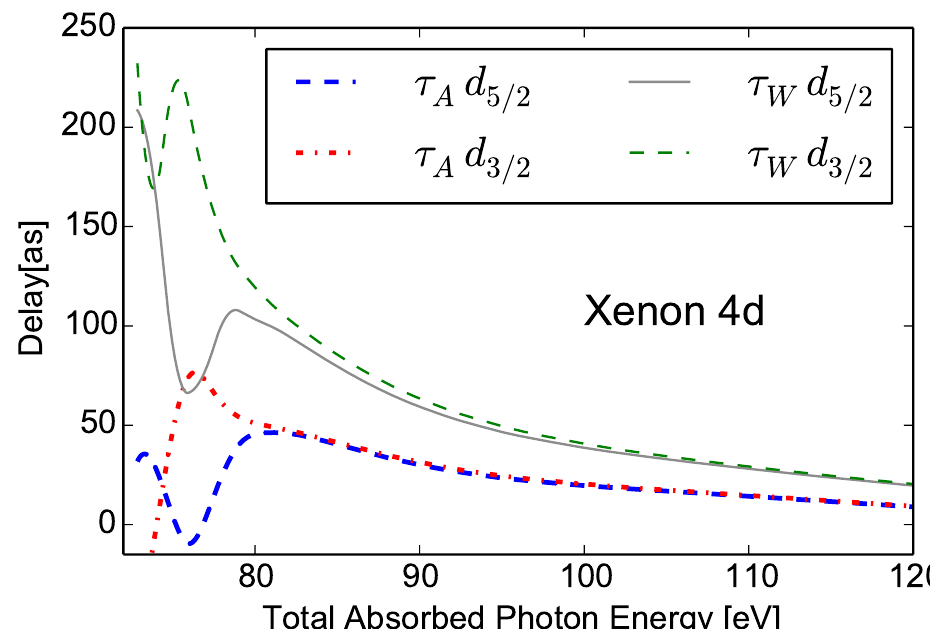
Figure 7. The thick dashed blue line shows the atomic delay for electrons ionized from 4 d 3/2 , and the dotted–dashed red line shows the atomic delay for electrons ionized from 4 d 5/2 . The thin dashed green and solid grey lines show the Wigner delay for electrons ionized from 4 d 3/2 and 4 d 5/2 respectively. Dirac–Fock orbital energies have been replaced with experimental ionization